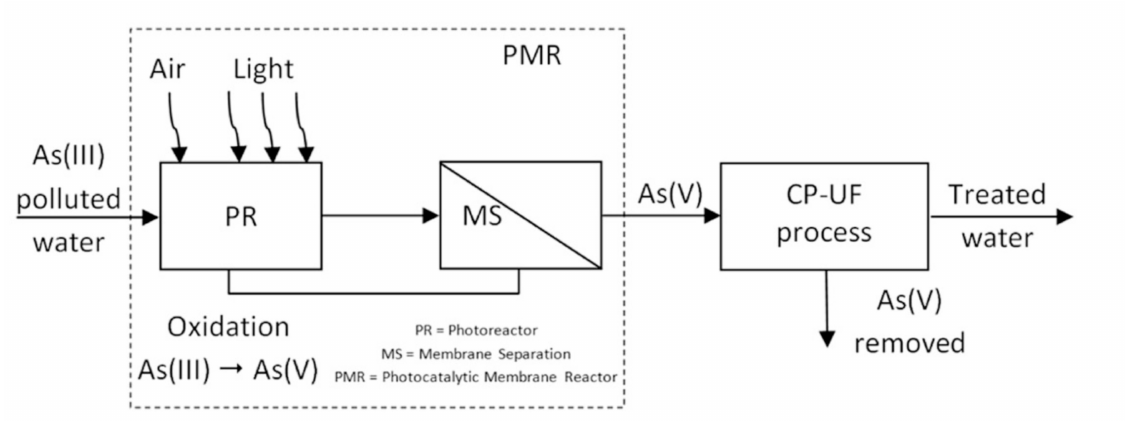
Figure 11. Conceptual coupling of photocatalysis and CP–UF (PR = photoreactor, MS = membrane separation; PMR = photocatalytic membrane reactor)